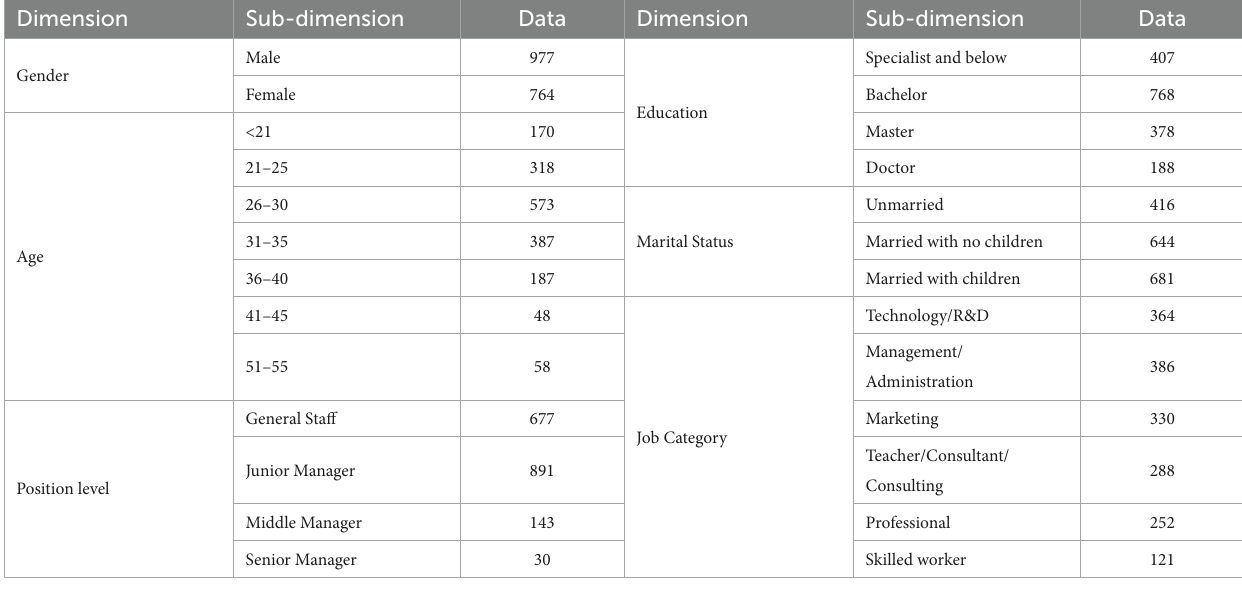
TABLE 2 Detailed data collection results.